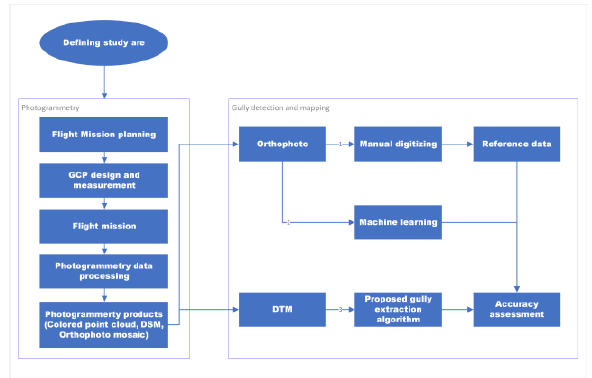
Figure 1. The workflow of this study